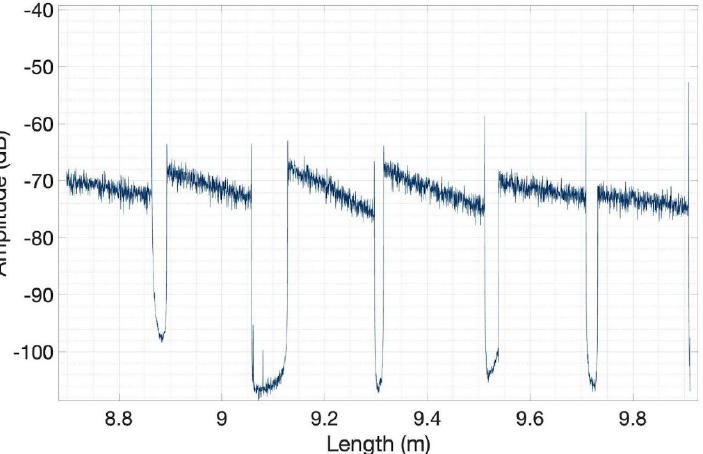
Figure 7. Backscattering trace, recording the Rayleigh backscattering intensity at every point along the fiber sensing network. The six regions with high intensity correspond to each nanoparticle- doped fiber span, while the low-intensity regions correspond to single-mode fibers used to distrib- ute the signal to each sensing